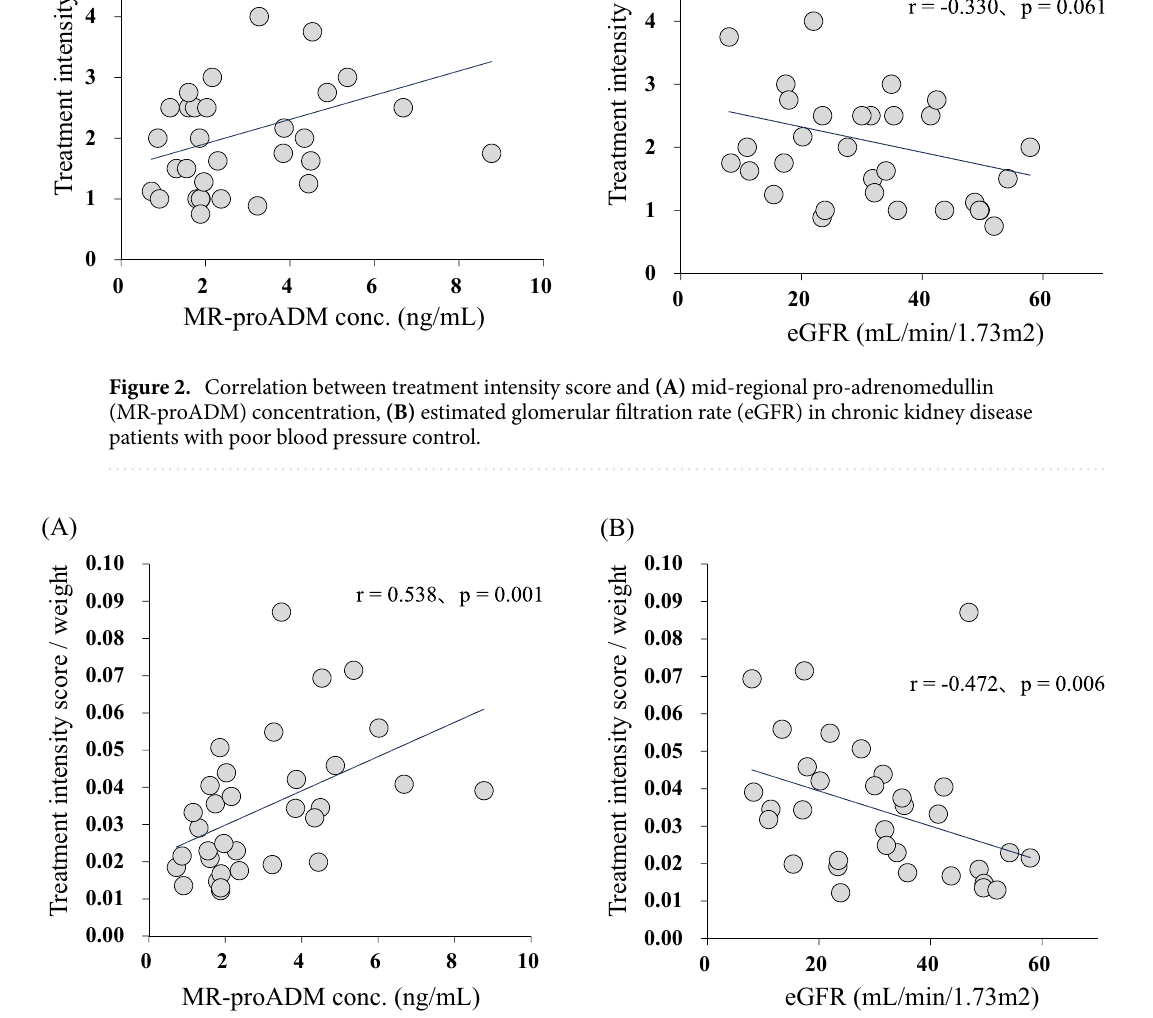
Figure 3. Correlation between weight-corrected treatment intensity score and (A) mid-regional pro- adrenomedullin (MR-proADM) concentration, (B) estimated glomerular filtration rate (eGFR) in chronic kidney disease patients with poor blood pressure